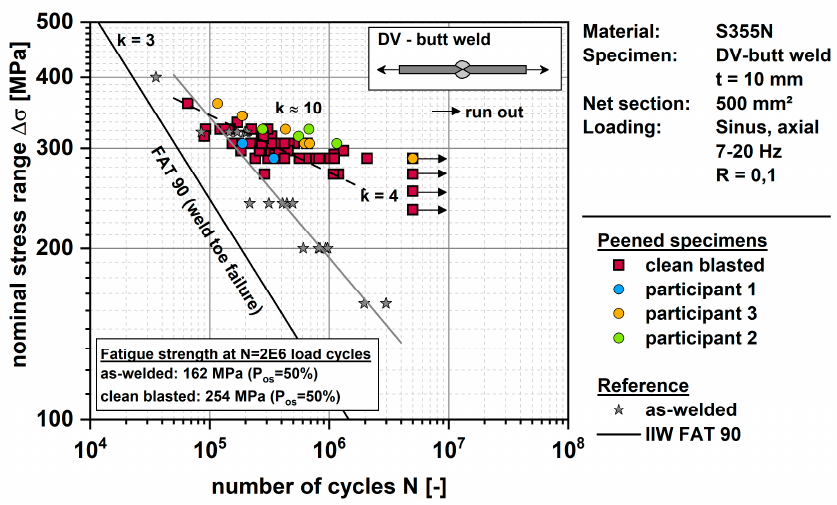
Figure 7. Fatigue test data of clean blasted DV-butt welds made from S355N. “Clean blasted” are results from test series 1–3, 10, 11, 14–17. Samples peened by participants 1 to 3 were clean blasted in industrial facilities and fatigue tested in Braunschweig (round robin principle).